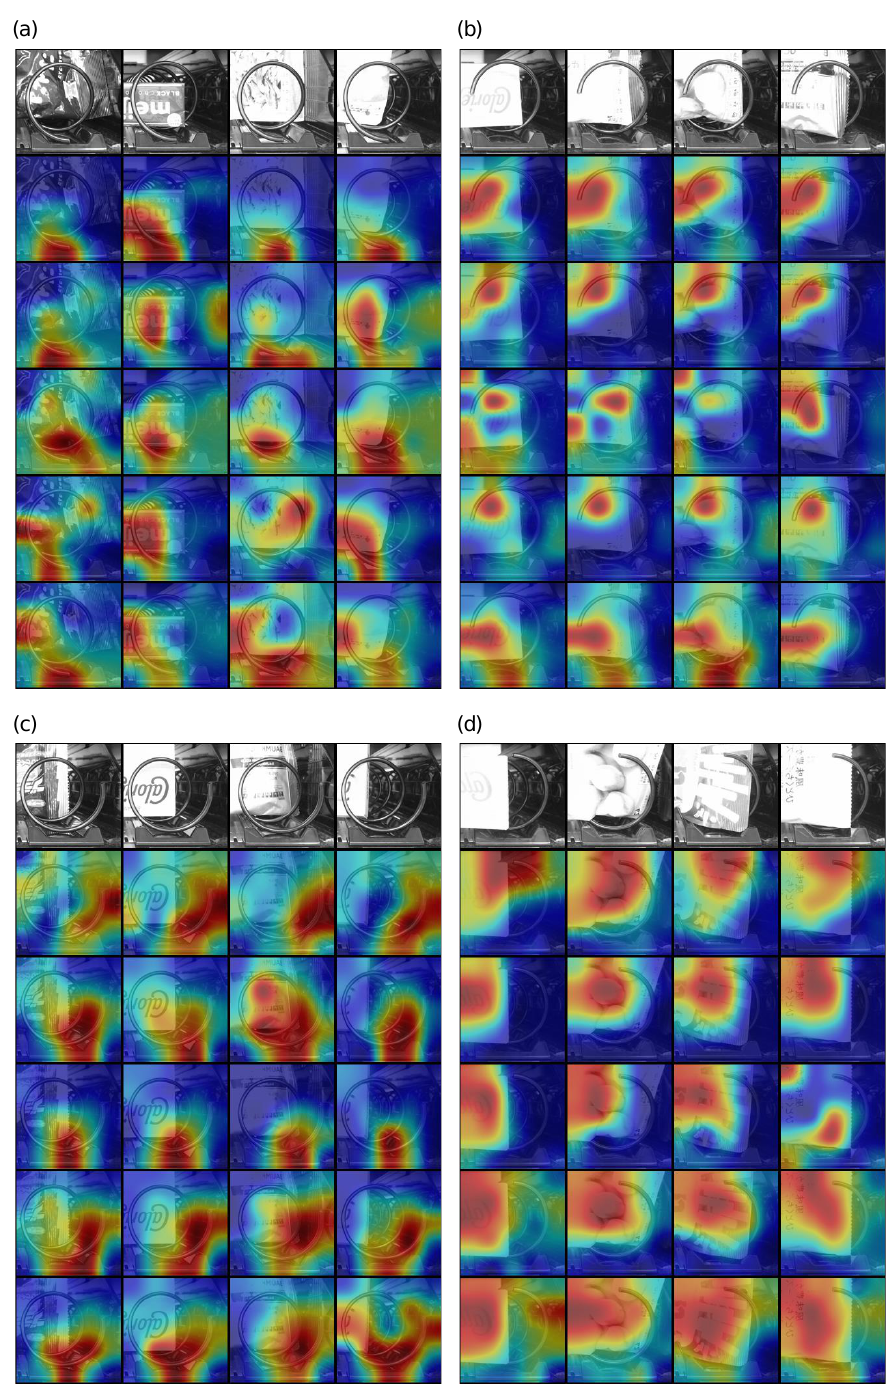
Figure 7. Grad-CAMs for 4 classes ( a ) “Down”, ( b ) “Left”, ( c ) “Right”, and ( d ) “Up”. For each subplot, the input images are in the first row, the second row shows the results of our proposal, and the subsequent rows show the results of cases ( a – d